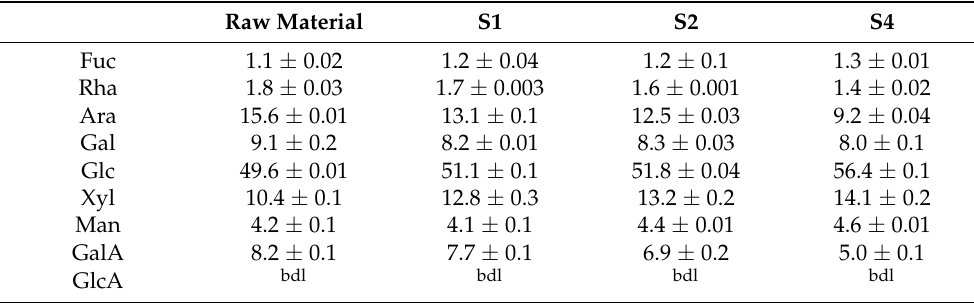
Table 2. Monosaccharide composition (mol%) of insoluble dietary fiber (IDF) of enzymatically treated apple pomace (raw and extruded) after sulfuric acid hydrolysis (mean value ± range/2, n = 2) Fuc: fucose, Rha: rhamnose, Ara: arabinose, Gal: galactose, Glc: glucose, Xyl: xylose, Man: